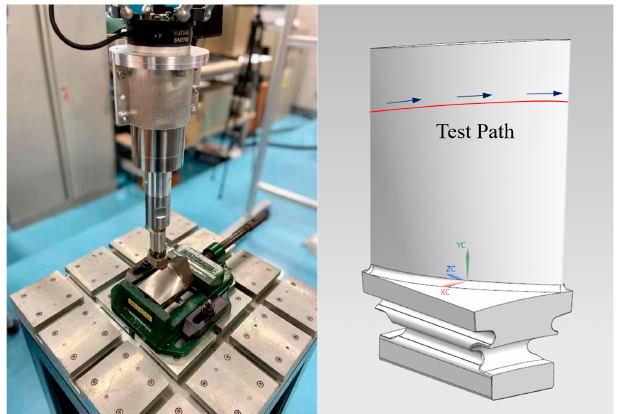
Figure 14. Contact force test on a single path.